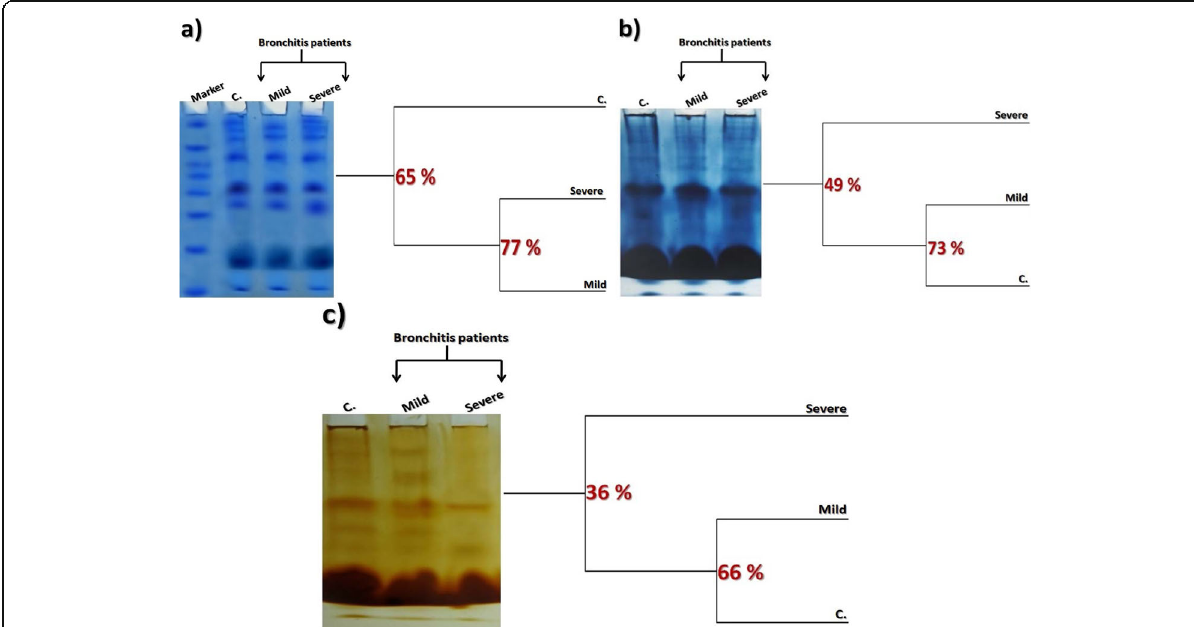
Fig. 1 Electrophoretic native patterns showing the physiological variations in bands number, arrangement and similarity percent (SI%) in a ) protein, b ) lipid moiety of native protein, and c ) calcium moiety of native protein in asthmatic bronchitis patients at mild and severe stages as compared to